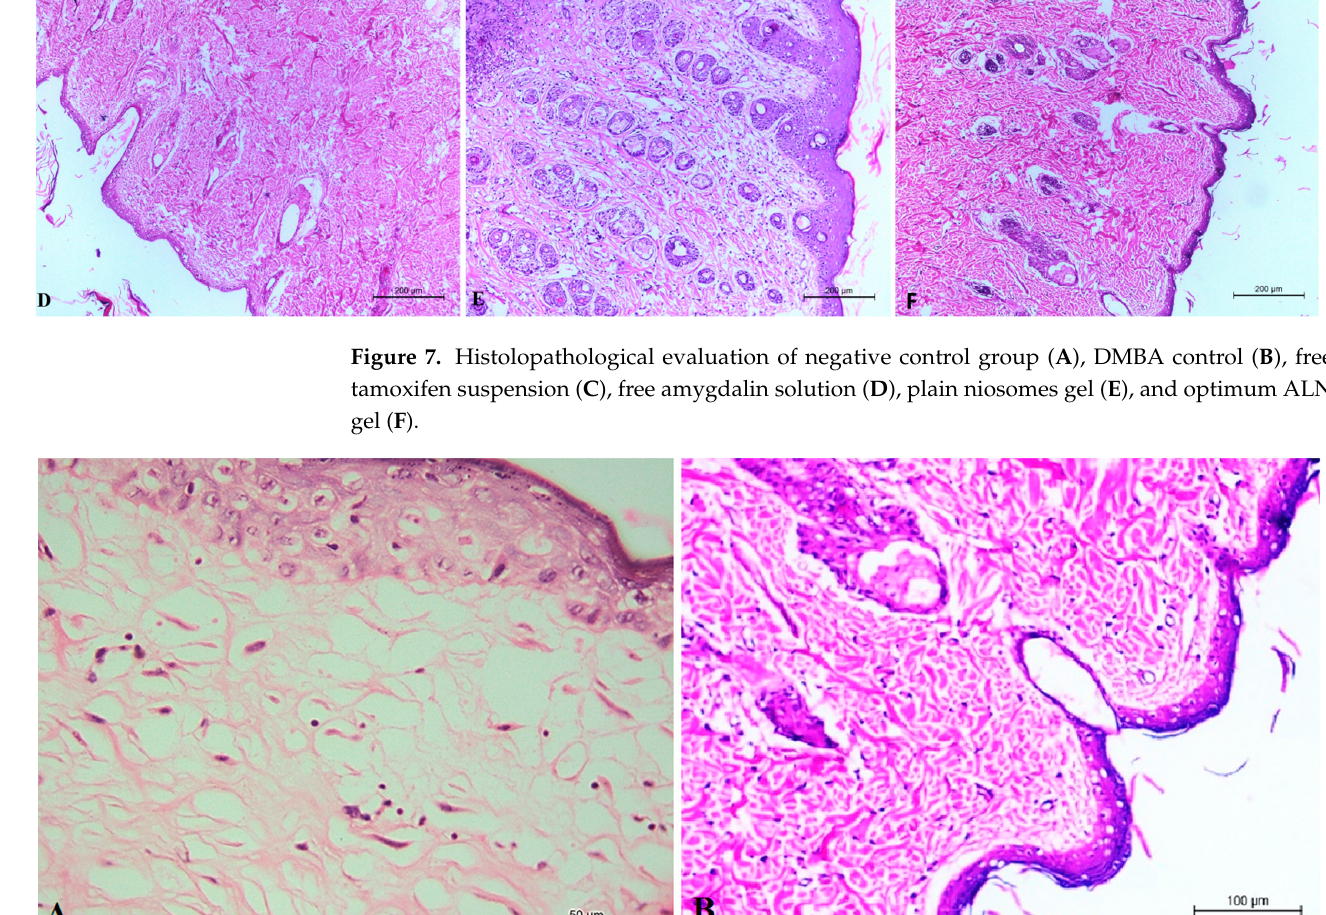
Figure 7. Histolopathological evaluation of negative control group ( A ), DMBA control ( B ), free tamoxifen suspension ( C ), free amygdalin solution ( D ), plain niosomes gel ( E ), and optimum ALN gel ( F ).